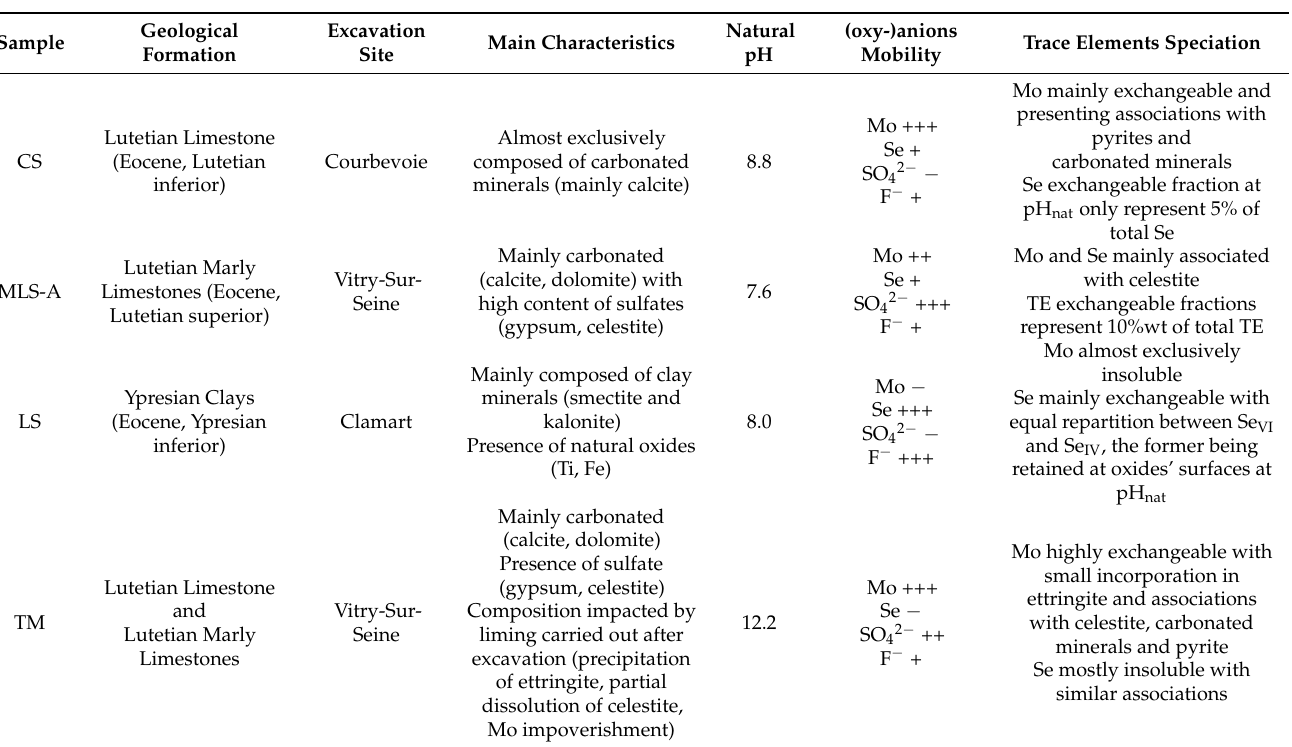
Table 1. Overview of raw excavated materials main characteristics as defined in previous work [8]. A scale for (oxy-)anions mobility commonly observed in each sample is proposed based on SBLT results: ( − ) weak mobility systematically below IWL acceptation criteria; (+) slight mobility with occasional overrun of IWL acceptation criteria; (++) strong mobility systematically above IWL acceptation criteria; (+++) highly concerning mobility leading to evacuation in more constraining waste landfills.